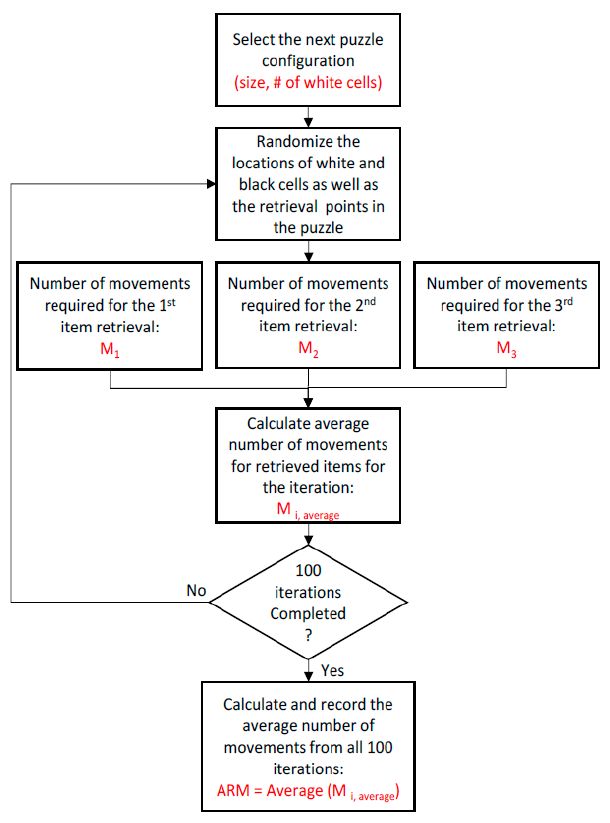
Figure 13. Steps of simulation.